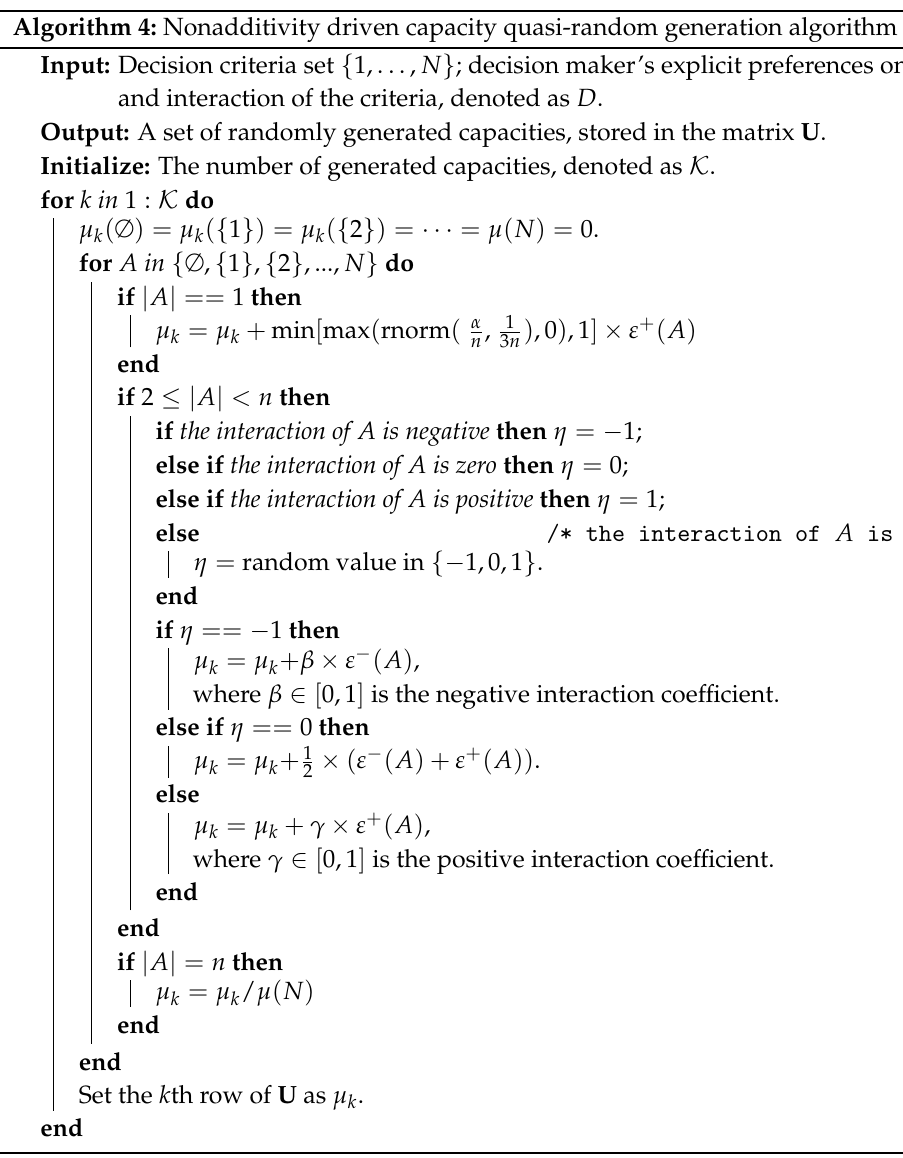
Algorithm 4: Nonadditivity driven capacity quasi-random generation algorithm